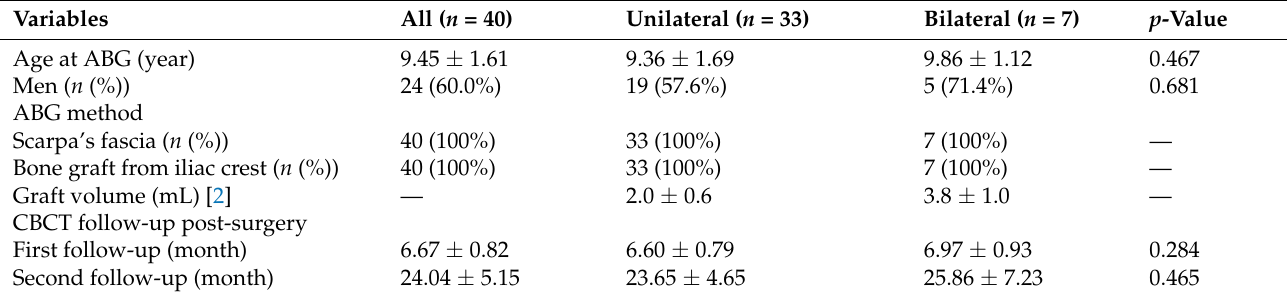
Table 1. Patient demographics and follow-up length.